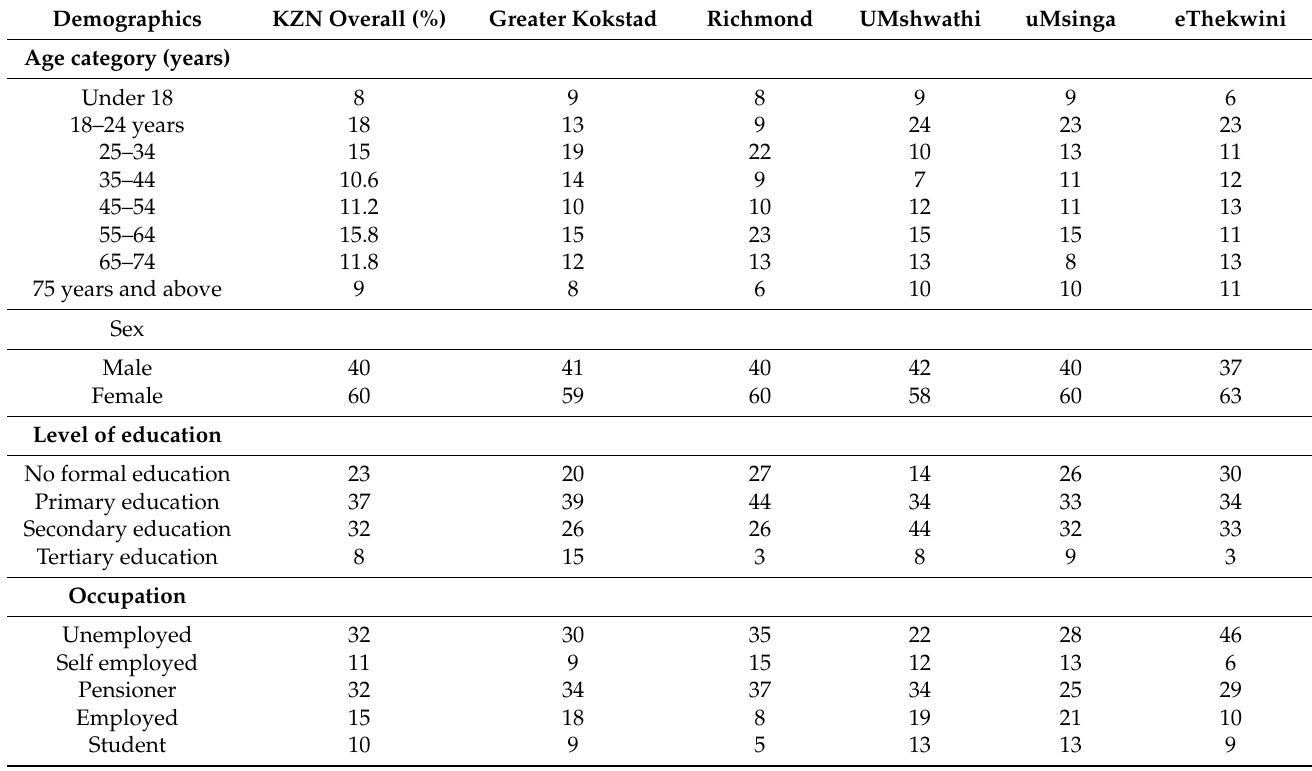
Table 2. Demographic information of the respondents in five local municipalities, KwaZulu-Natal ( n = 500), South Africa.